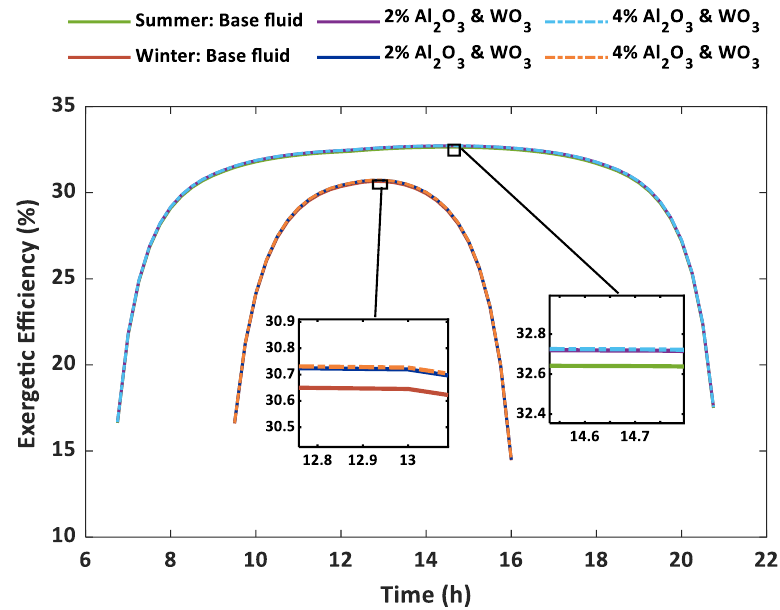
Figure 13. Thermal efficiency of the base fluid and HNFs for sunny and winter days in Budapest.